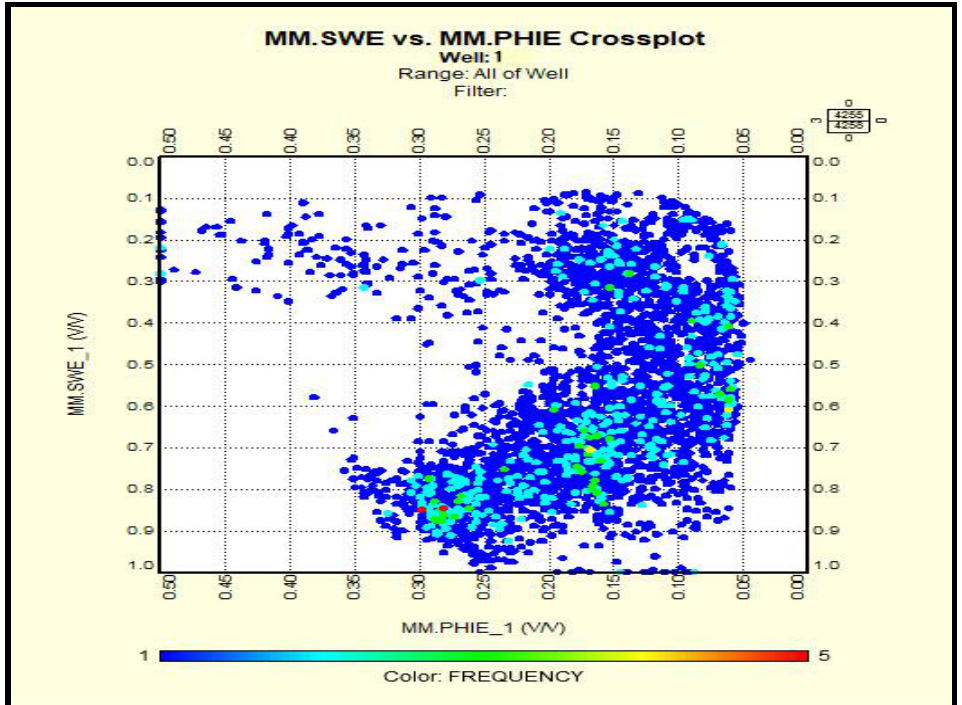
Figure 4. Cross-plot of effective porosity against effective water saturation for Sarvak Formation. Interpretation and